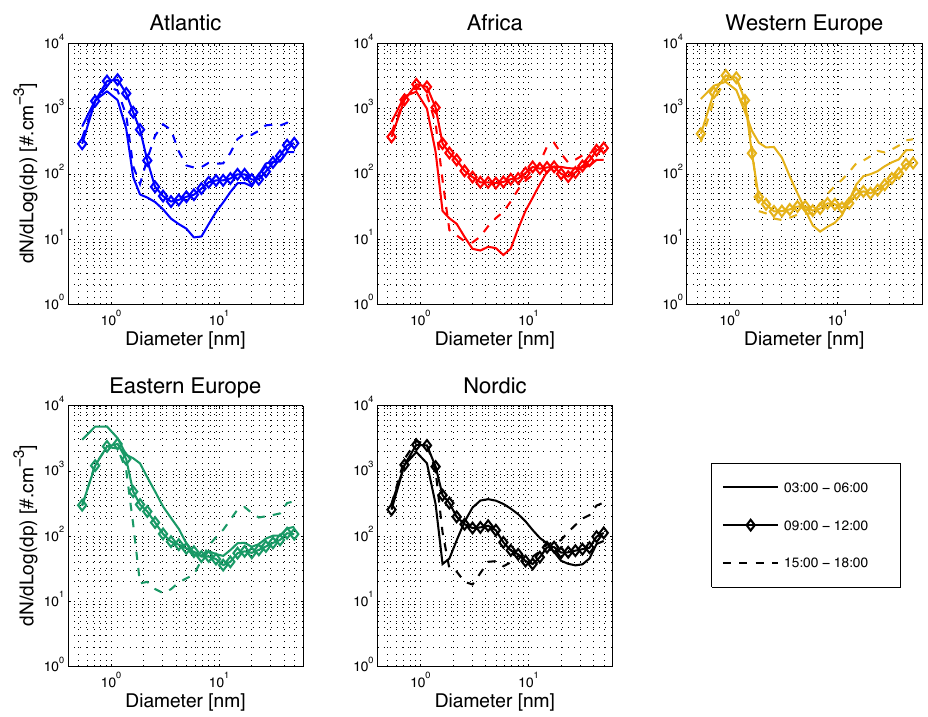
Fig. 7b. Positively charged aerosol distribution of different types of air mass origin endings at Jungfraujoch at 00:00 LT for event days.